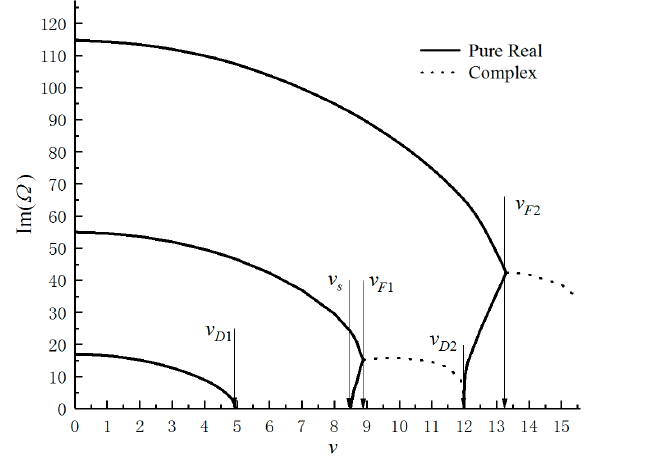
Figure 3. Curve of the imaginary part of the first three complex frequencies of SS beam changing with axial velocity.